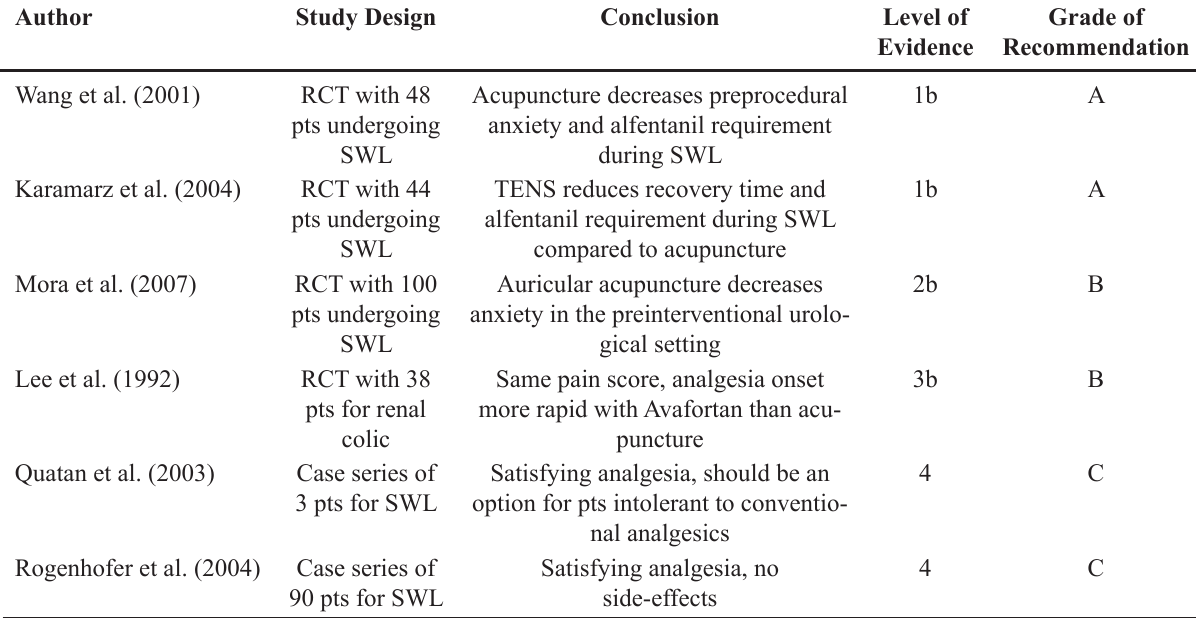
Table 2 – Acupuncture article